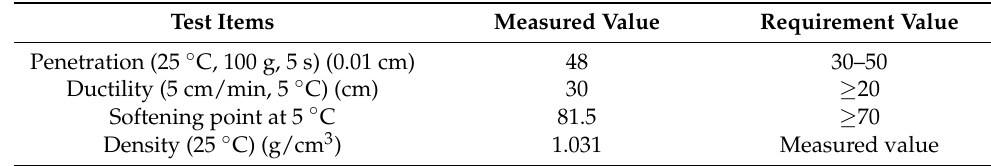
Table 1. Basic technical indicators of asphalt binder.